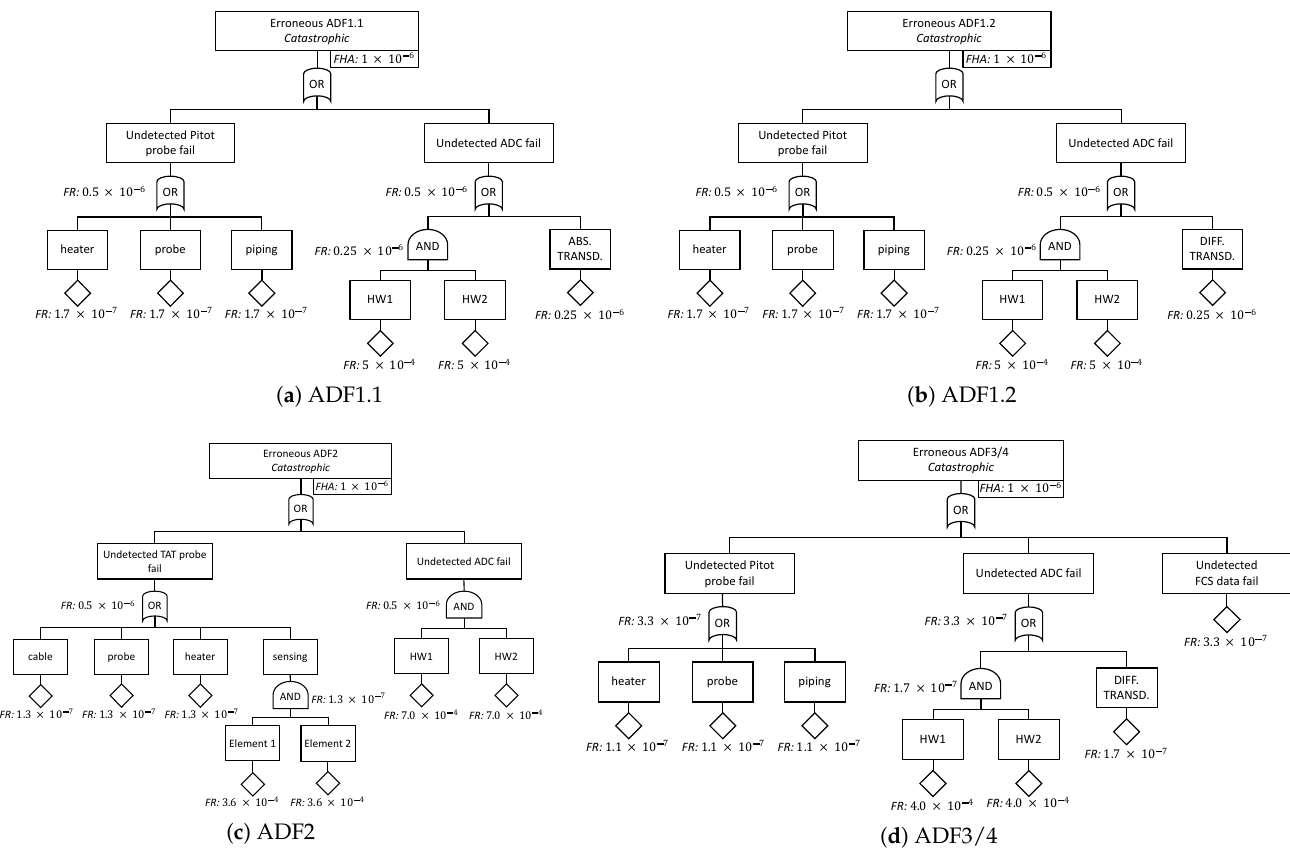
Figure 4. Preliminary System Safety Assessment (PSSA) for air data